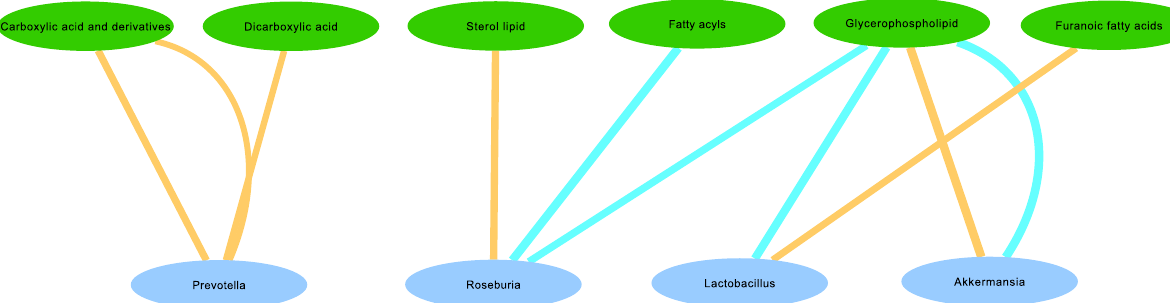
Fig. 3 Network of selected within-PD correlations. Network of within-PD correlations between bacterial genera and metabolite classes using selected results (Table 4). Edge thickness represents the strength of the correlation. Blue edges represent positive correlations, and Orange edges represent negative correlations. Green nodes represent metabolite classes, and Cyan nodes represent bacterial